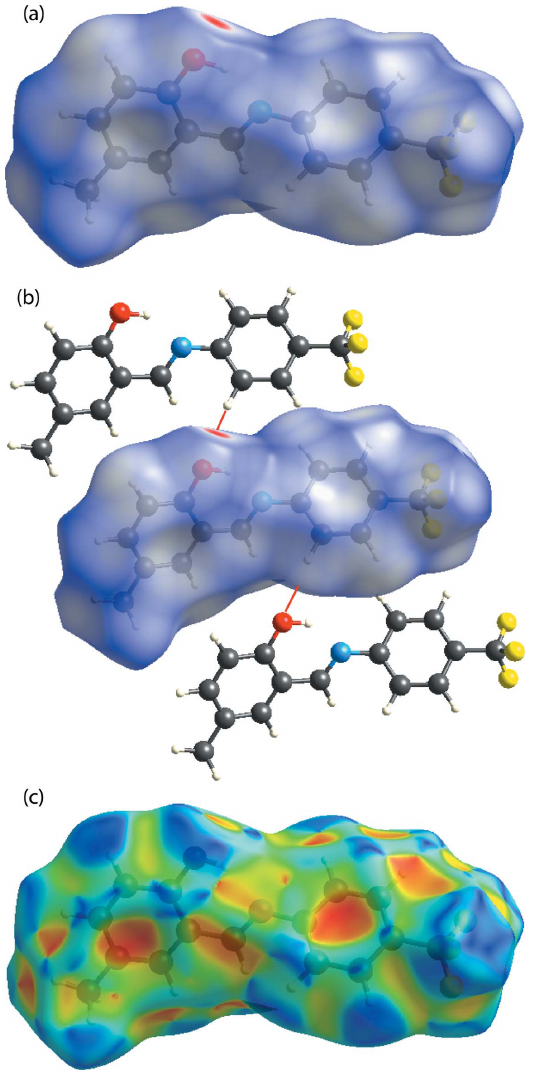
Figure 5 ( a ) The overall two-dimensional finger print plot for (I) and those delineated into: ( b ) C (cid:2)(cid:2)(cid:2) H/H (cid:2)(cid:2)(cid:2) C (29.2%), ( c ) H (cid:2)(cid:2)(cid:2) H (28.6%), ( d ) F (cid:2)(cid:2)(cid:2) H/ H (cid:2)(cid:2)(cid:2) F (25.6%), ( e ) O (cid:2)(cid:2)(cid:2) H/H (cid:2)(cid:2)(cid:2) O (5.7%) and ( f ) F (cid:2)(cid:2)(cid:2) F (4.6%)